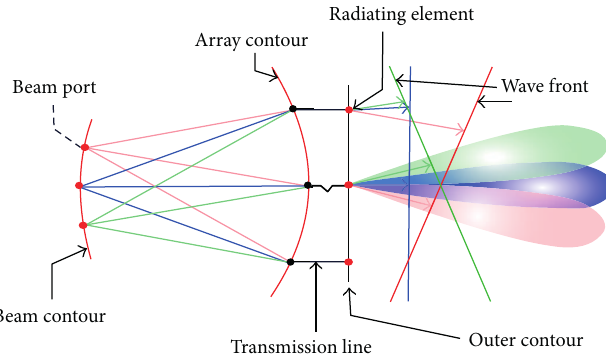
Figure 1: A conceptual diagram of a Rotman